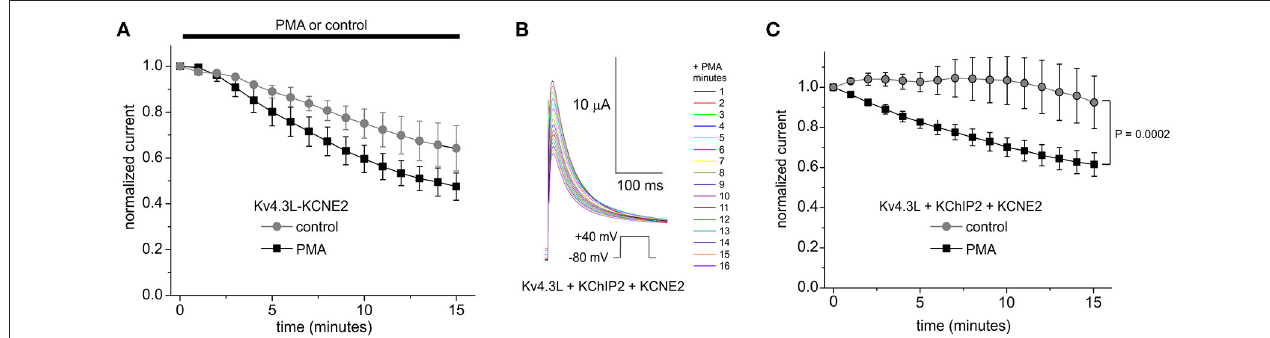
FIGURE 6 | KCNE2 restores the PKC sensitivity of Kv4.3L-KChIP2b activity. (A) Mean ± SEM normalized peak current magnitude at + 40 mV (1 pulse per minute) during incubation in 50 nM PMA ( n = 11–12) or normal bath solution (control; n = 5) for Kv4.3L with KCNE2. (B) Exemplar current traces recorded during + 40 mV pulses (1 per minute) in the presence of 50 nM PMA, from Xenopus oocytes expressing encoding Kv4.3L with KCNE2 and KChIP2b. Insets: center, color-coded key to traces; lower left, voltage clamp protocol. (C) Mean ± SEM normalized peak current magnitude at + 40 mV during incubation in 50 nM PMA ( n = 8) or normal bath solution (control; n = 5) for cells as in (B)